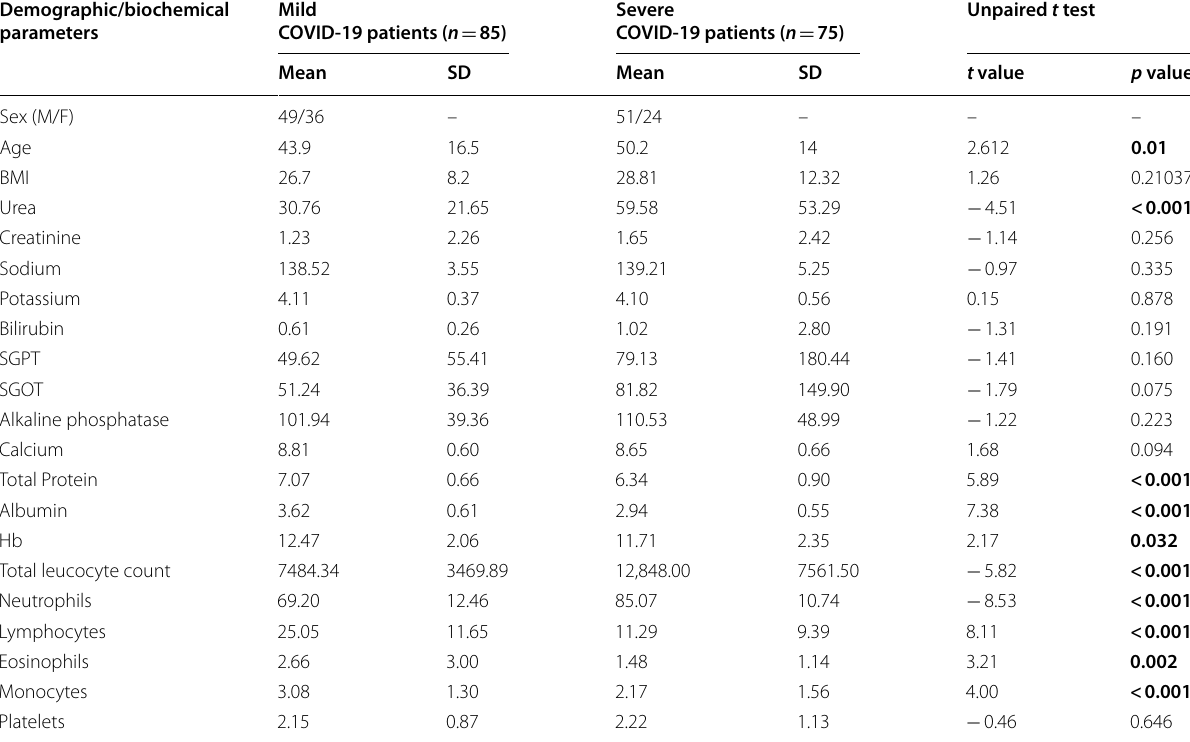
Statistically signficant values are shown in bold n number, % percentage, SD standard deviation, SGPT serum glutamic pyruvic transaminase, SGOT serum glutamic oxaloacetic transaminase, Hb hemoglobin Significant association ( p < 0.05)